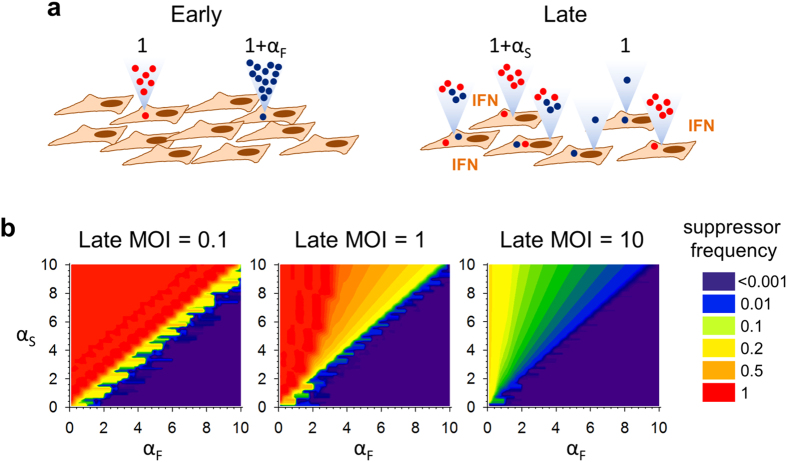
Fitness tradeoffs model for the evolution of IFN suppression.(a) Conceptual scheme of the model. Host cells are pictured in brown, and the IFN-suppressing and non-suppressing variants in red and blue, respectively. Released viral progeny is represented with dots inside triangles. During early steps of the infection, the virus spreads rapidly in the absence of IFN, and a fast-growing variant has a relative fitness of 1 + αF. During late infection, viral spread is partially inhibited by IFN-mediated antiviral responses, and hence IFN suppressors have a relative fitness of 1 + αS. In cells co-infected with fast growers and suppressors, relative fitness differences are offset because viral products are provided in trans. (b) Numerical solution of the model for three different MOIs and a range of αF and αF beneficial selection coefficients. Alternated first and second cycles were simulated until a stable equilibrium was reached or one of the two variants became fixed. Colors indicate the final population frequency of the suppressor variant. QS < 0.0001 (purple) indicates loss of the IFN suppressing virus, and QS = 1 (red) indicates fixation.